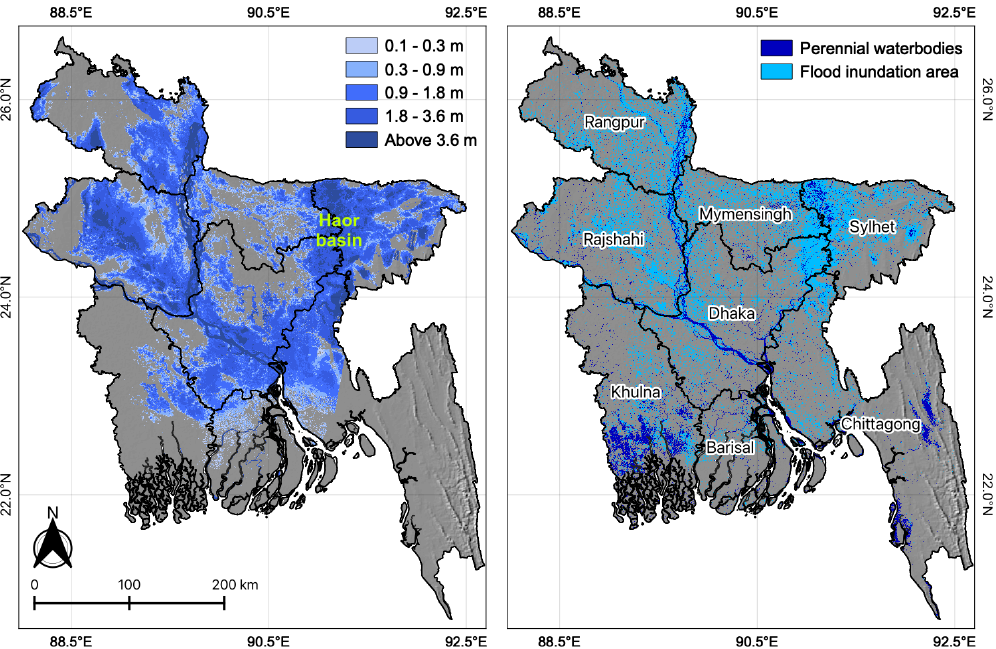
Figure 1. FFWC’s flood forecast issued on 16 August 2017 (left panel) and Sentinel-1-based satellite flood inundation for the August 2017 (right panel) flood event. The borderline represents the boundary of divisions.